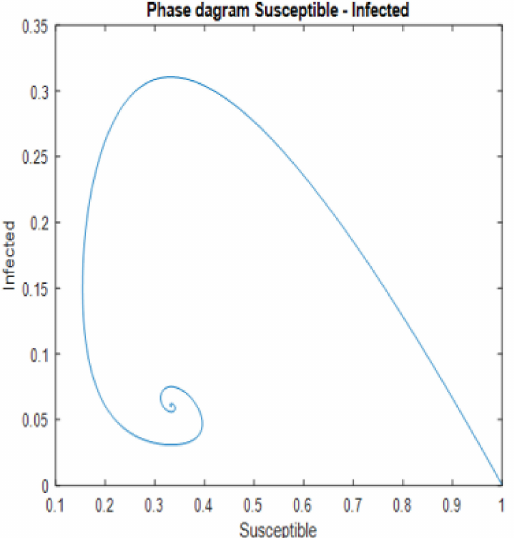
Figure 8. Phase portrait of I against S, for the stable state of the CSIR